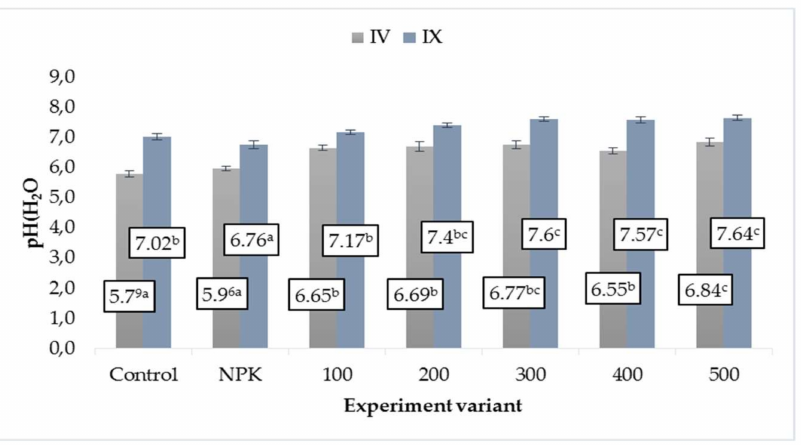
Figure 2. Changes in the pH of the chernozem soil in the 0–5 cm layer in IV (April) and IX (September) 2021 after the application of biomass combustion ashes (mean ± SD). Treatments not sharing the same letter(s) are statistically significant at p < 0.05 (Tukey’s